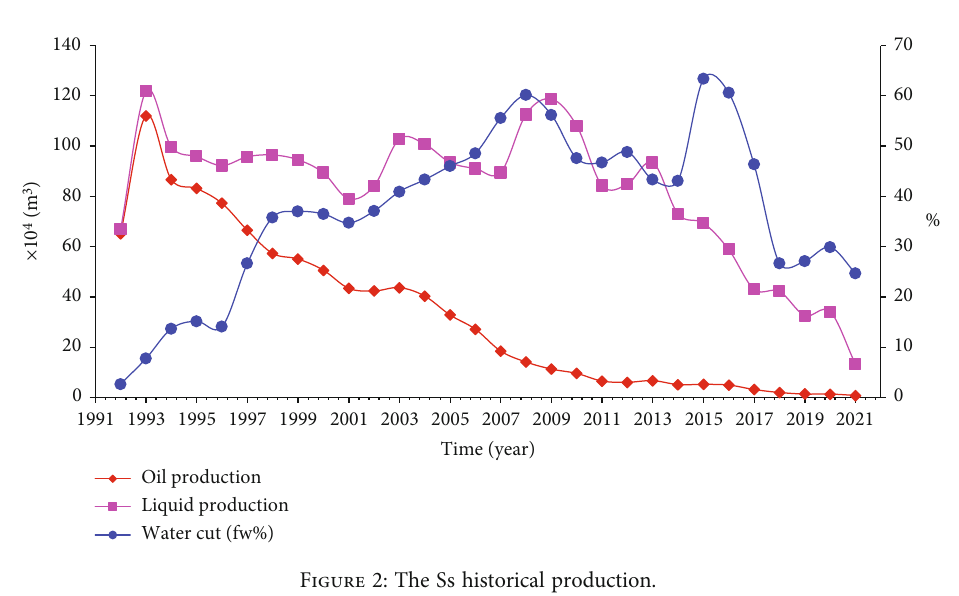
Figure 2: The Ss historical